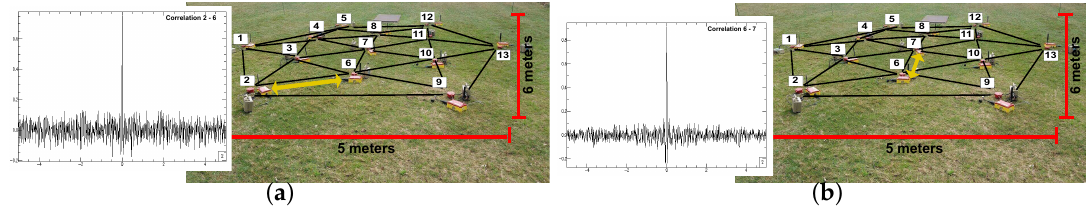
Figure 18. Cross-correlation results after stacking the measurements over 1 h: ( a ) C 2 − 6 ; and ( b ) C 6 − 7